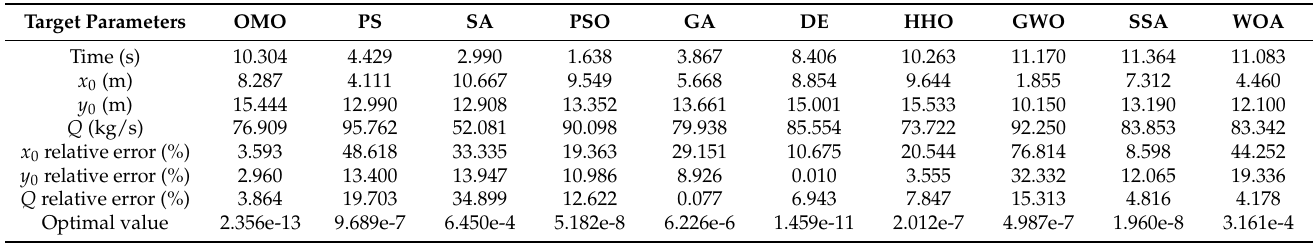
Table 17. Comparison of results of different optimization algorithms under 9 sensors.